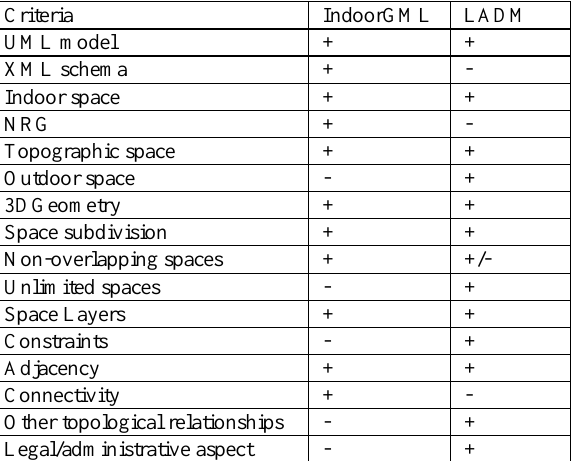
Table 1: IndoorGML and LADM: a comparison